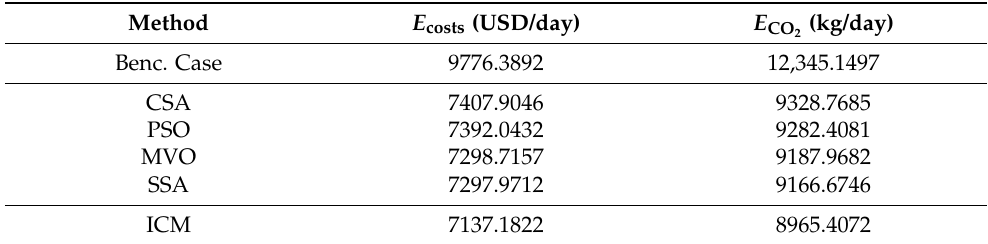
Table 3. Numerical results regarding the minimization of E costs and E CO proposed